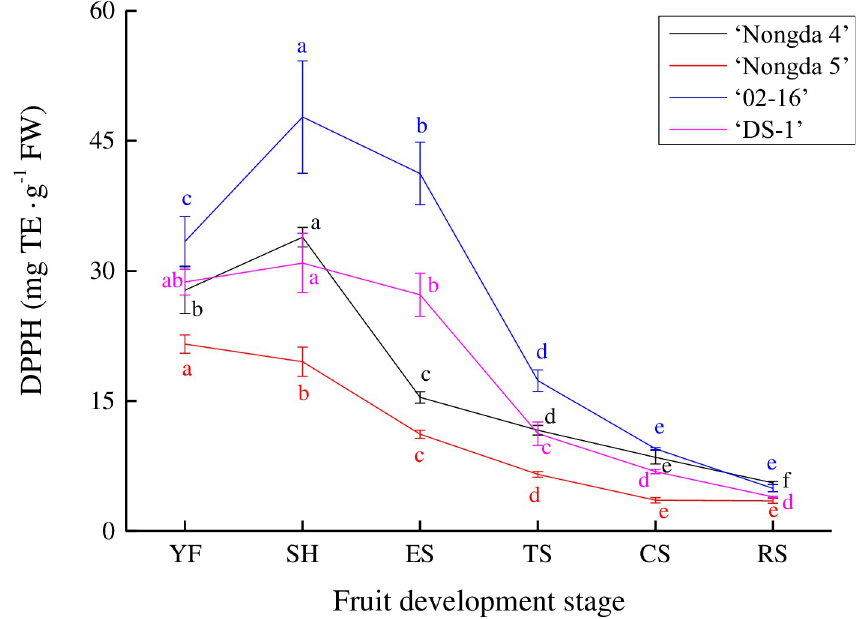
Fig 3. Dynamic change of DPPH scavenging ability in Prunus humilis fruit. Note: The same color letters indicate significance at P < 0.05. FW, Fresh weight; TE, Trolox equivalent; DPPH, 2,2-diphenyl-1-picrylhydrazyl free radical scavenging capacity; YF, Young fruit stage; SH, Stone hardening stage; ES, Expension stage; TS, Turning stage; CS, Coloring stage; RS, Ripening stage.